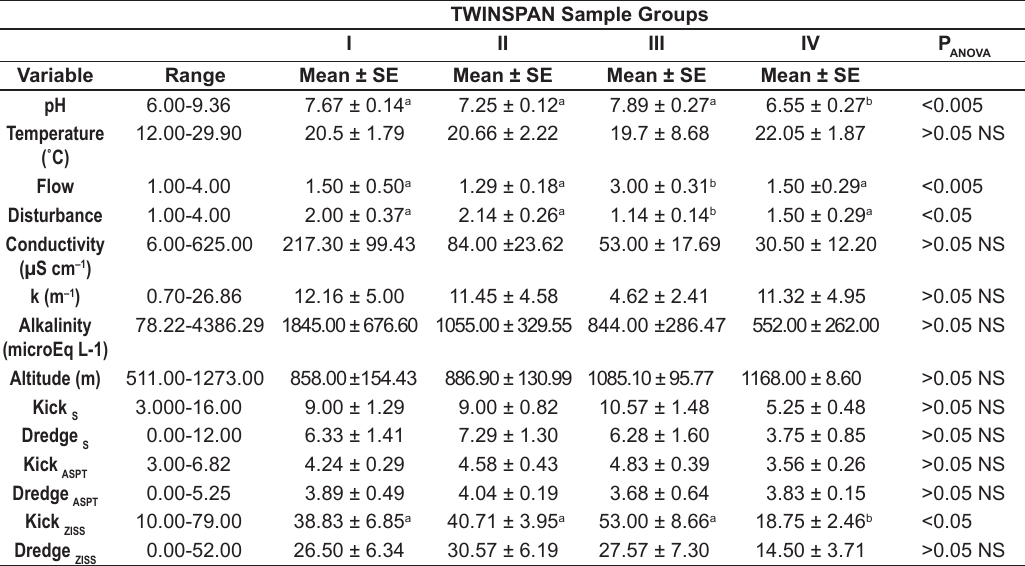
Table 2. Environmental and biological parameters: range of data for all 25 sites, and mean ± standard error (SE) for each of four TWINSPAN sample groups compared by